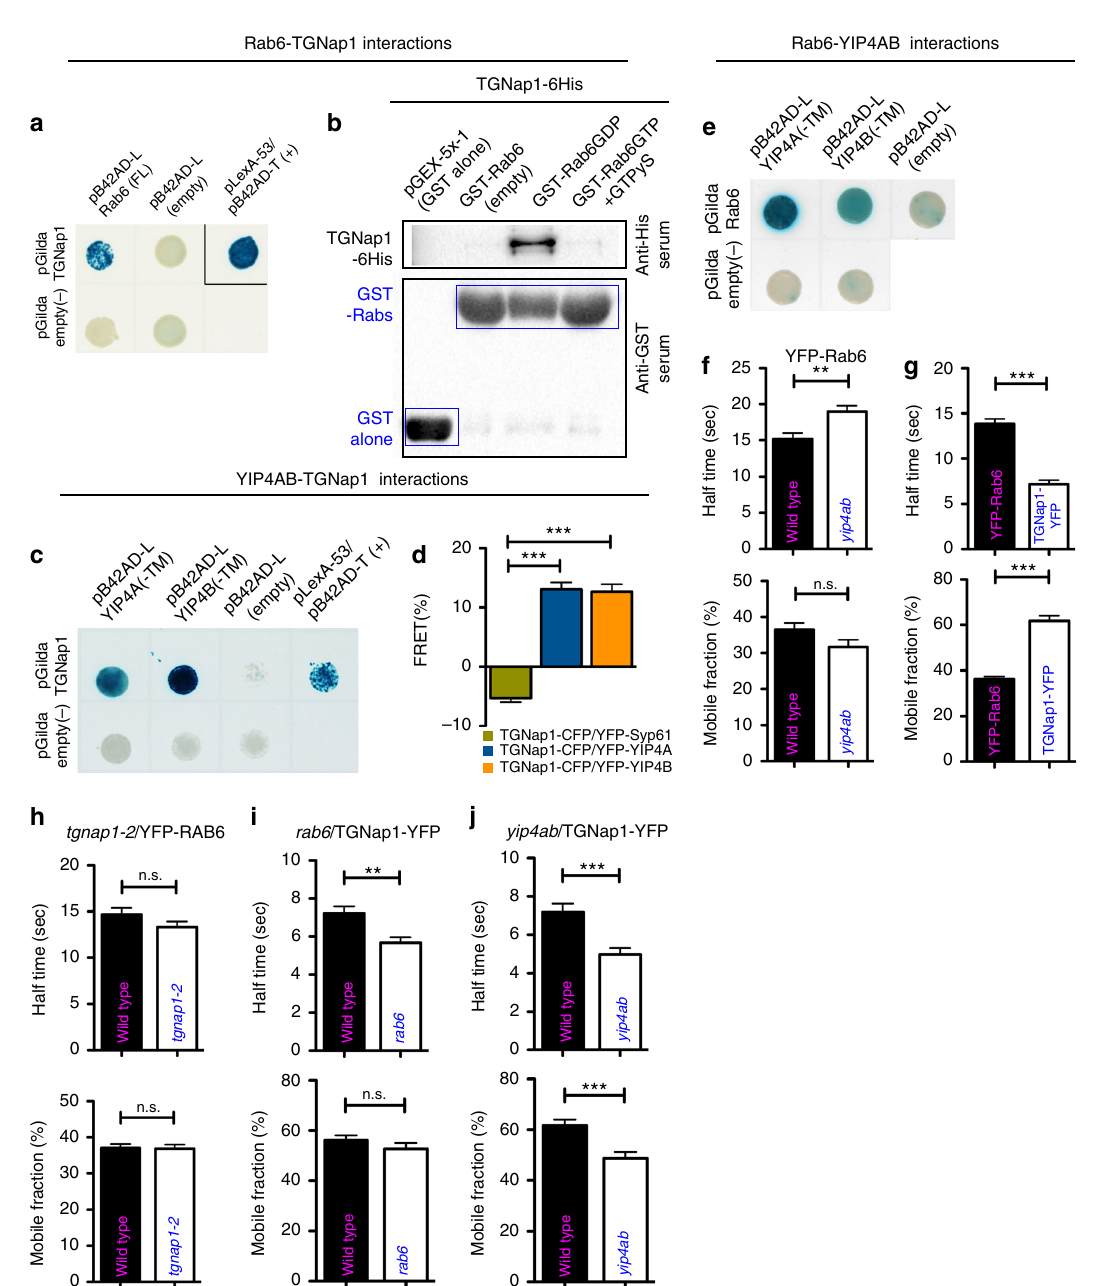
Fig. 5 TGNAp1, RAB6, and YIP4A and B interactions and dynamics. a Y2H assay between TGNap1 and Rab6 (blue colonies: positive interaction, white colonies: negative controls). b Western blot on pull-down analyses between TGNap1 and Rab6 (anti-GST lanes: loading control). c Y2H assay between TGNap1 with YIP4A and YIP4B. d FRET analyses between TGNap1-CFP and either YFP-Syp61 (negative control) ( n = 47) or YFP-YIP4A ( n = 39), and YFP- YIP4B ( n = 46) at the TGNs. e Y2H assay between Rab6 with YIP4A and YIP4B. f FRAP analyses on YFP-Rab6 in WT ( n = 46) and yip4ab ( n = 51). g FRAP analyses on TGNap1-YFP ( n = 58; half-time = 7.18 ±0.43) and YFP-Rab6 ( n = 59; half-time = 15.18± 0.85). n = number of independent data points. h FRAP analyses on YFP-Rab6 in WT and tgnap1 – 2 showing no signi fi cant differences in the dynamics in the two backgrounds, respectively: n = 55; half-time = 14.69±0.70 and n = 55; half-time = 13.32±0.60. i FRAP analyses on TGNap1-YFP in WT and rab6 . In WT, TGNap1-YFP cycles on and off the TGN membranes with a half-time = 7.21 ±0.38 ( n = 49); however, when the cellular abundance of RAB6 is reduced compared to WT, TGNap1-YFP cycles at a signi fi cantly higher rate ( n = 52; half-time = 5.67± 0.29). j FRAP analyses on TGNap1-YFP in WT and yip4ab show a signi fi cant increase in the cycling of TGNap1-YFP on and off the TGN membranes when YIP4 is not available ( n = 47; half-time = 4.96± 0.34) compared to WT ( n = 59; half-time = 7.18± 0.43). Error bars indicate S.E.M; Student t -test was applied, p -values are represented by asterisks when signi fi cantly different from the corresponding control: *** p < 0.001; **0.001 > p < 0.01; n.s., not signi fi cant. Source data are provided as a Source Data fi